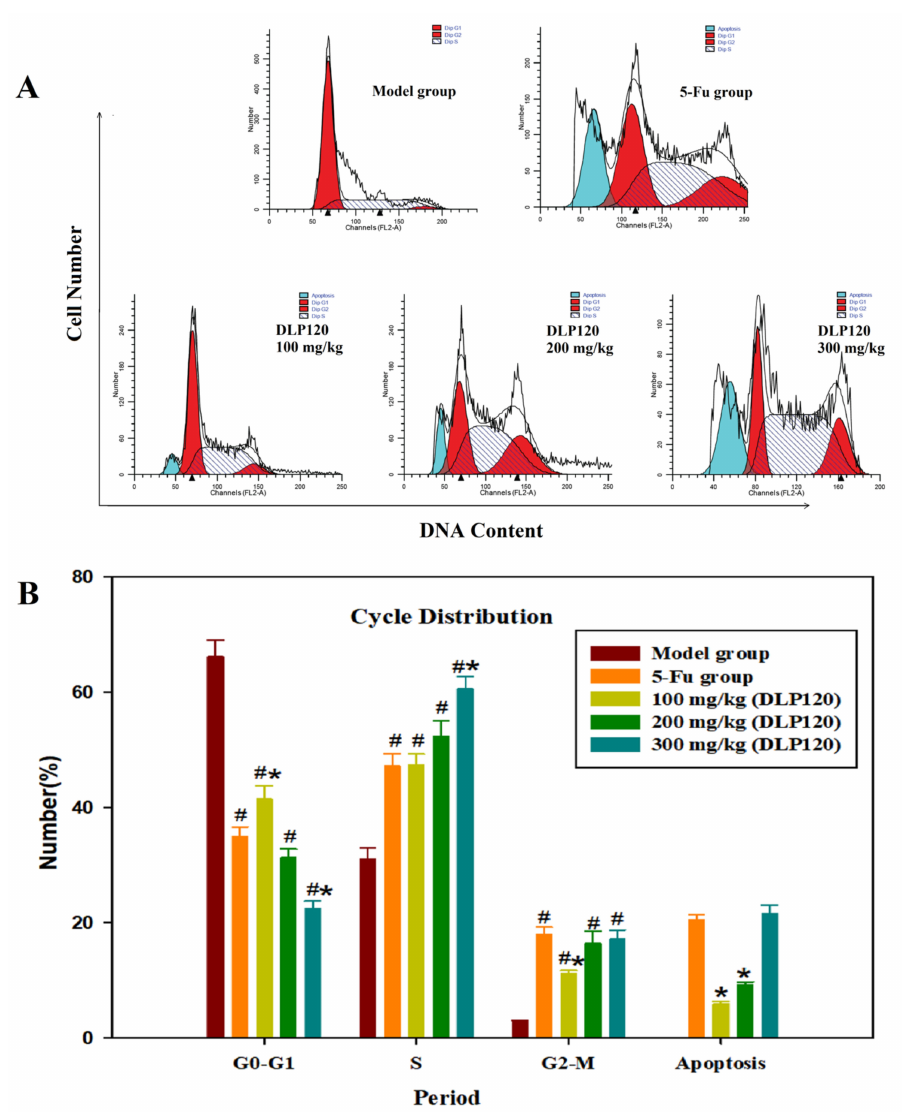
Figure 6. Tumor cell cycle proportions ( A ). Bar graph summarizing the data on cell cycle distribution ( B ). Note: # p < 0.05,compared to model group; * p < 0.05, compared to 5-Fu